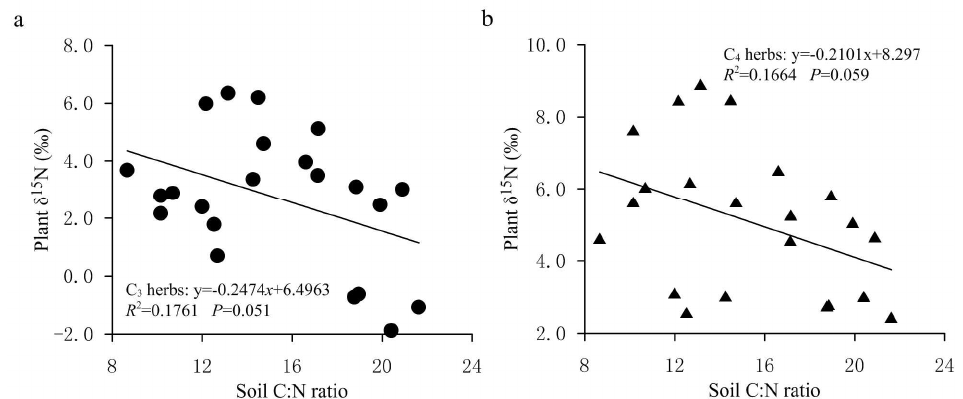
Figure 4. The changes in the δ 15 N values for C3 and C4 herbs with soil C: N ratio in the study area. ( a ) Relationship between δ 15 N values of C3 herbs and soil C: N ratio. ( b ) Relationship between δ 15 N values of C4 herbs and soil C: N ratio.